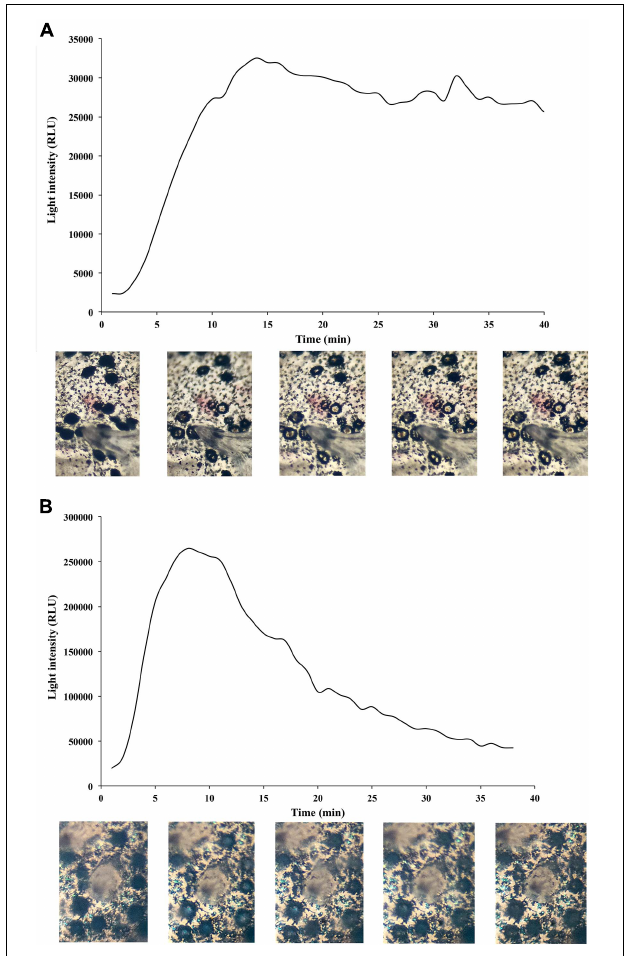
FIGURE 7 | Time-course of MT-induced luminescence, and time-lapse of photophore pigment movements. Luminescence in relative light unit (RLU) recorded during a 40 min MT 10 − 6 mol L − 1 application on ventral skin patches and time-lapse pictures (times: 0, 10, 20, 30, and 40 min, respectively) of photophore pigment movements of (A) Dalatias licha , (B) Etmopterus lucifer